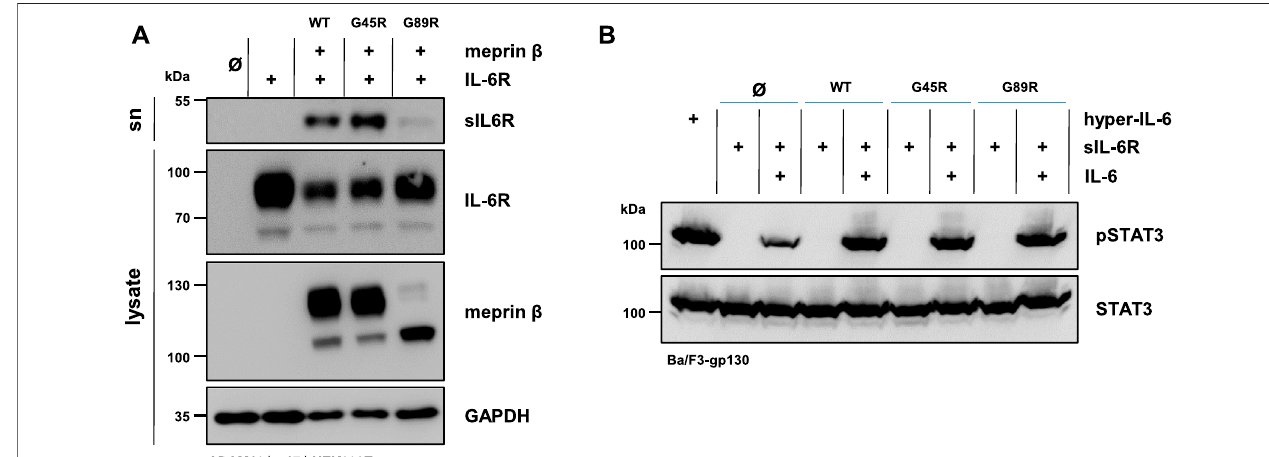
FIGURE 3 | Meprin β -dependent shedding of the IL-6R and induced trans-signaling. (A) Immunoblots of ADAM10 − / − ; 17 − / − HEK293T cells transiently transfected with a control plasmid (Ø), IL-6R alone, and together with one of the indicated meprin β variants. Supernatants (sn) were ultracentrifuged and analyzed for sIL-6R. IL-6R and sIL-6R were detected with an antibody directed against the D1-domain of IL-6R and meprin β with an anti-Flag antibody. GAPDH served as the loading control. Of note, the amount of sIL-6R in the supernatant was increased upon the co-expression of G45R compared with meprin β WT. (B) Phosphorylation of STAT3 in Ba/ F3-gp130 cells stably transfected with gp130. Cells were treated with ultracentrifuged supernatants from the experiments in (A) and the phosphorylation of STAT3 was analyzedinthepresenceandabsenceof150 ngrecombinantIL-6.ThesameamountofthefusionproteinconsistingofsolubleIL-6RandIL-6(hyper-IL-6)servedasthe positive control. Phosphorylation was detected with an antibody raised against phosphorylated STAT3 (pSTAT3). Total STAT3 protein served as the loading control. Western blot quanti fi cation of generated sIL-6R and pSTAT3 from three biologic replicates is presented in Supplementary Figure S2 .